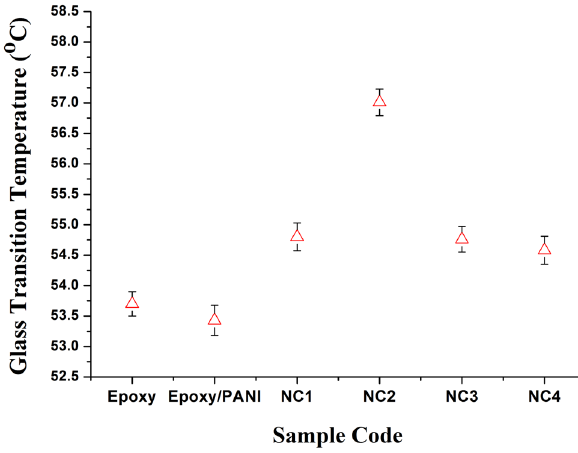
Figure 4: Glass transition temperature of epoxy, epoxy/PANI, and